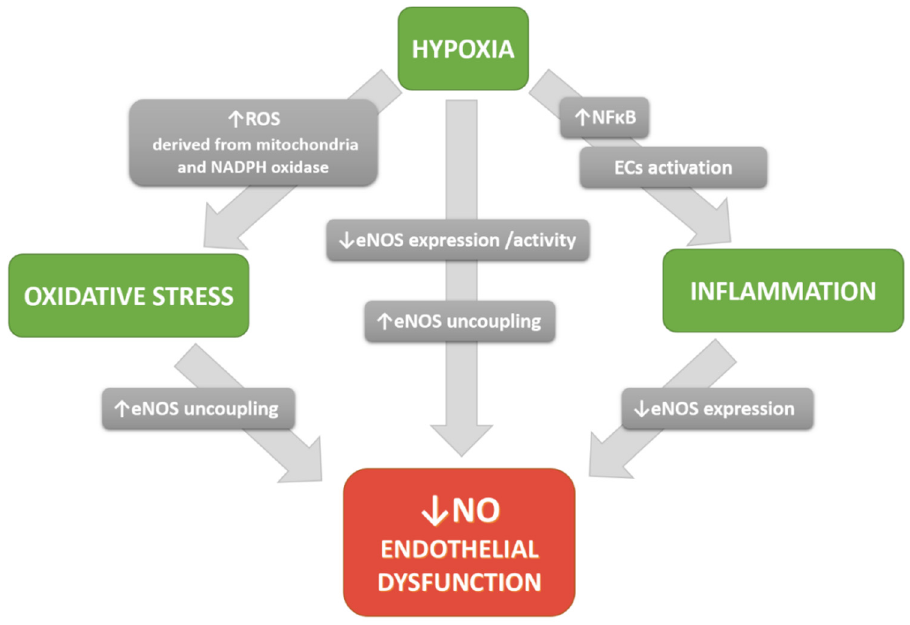
Figure 3. Scheme illustrating the influence of hypoxia on NO bioavailability—major pathways regulating NO bioavailability in the endothelium and the interrelationship between them.